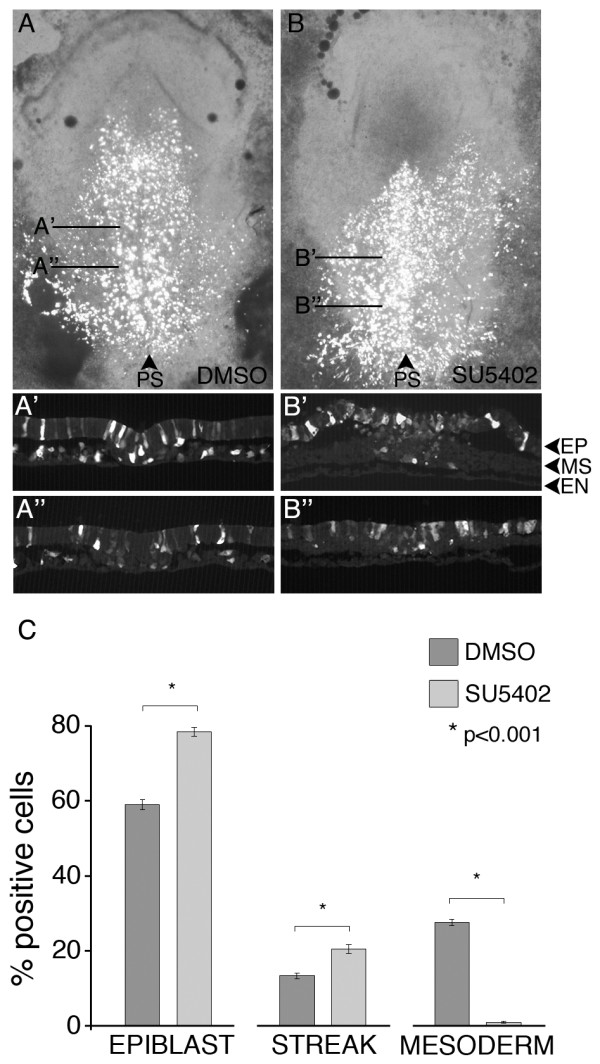
Inhibition of FGFR activity blocks cell migration from the epiblast through the primitive streak to the mesoderm. A-B: Combined brightfield and fluorescence images of control (A) or SU5402 treated (B) embryos. Embryos were treated for two hours with DMSO carrier or SU5402, and then electroporated with a GFP expression construct. A'-A": indicates transverse sections through the control embryo in A; B'-B": represents transverse sections through the embryo shown in B. C: Quantification of GFP-expressing cell location at 5 hours after electroporation. EPIBLAST includes preingression epiblast and lateral epiblast extending to the area pellucida-opaca border; STREAK includes the primitive streak; MESODERM includes the medial and lateral mesoderm regions to the area pellucida-opaca border (see Figure 1A for depiction of domains). Migration of cells to the mesoderm is essentially abolished in SU5402 treated embryos. Abbreviations: PS, primitive streak; EP, epiblast; MS, mesoderm; EN, endoderm.